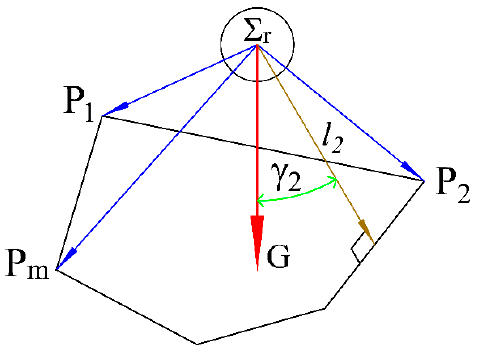
Figure 6. Robot tip-over angles.